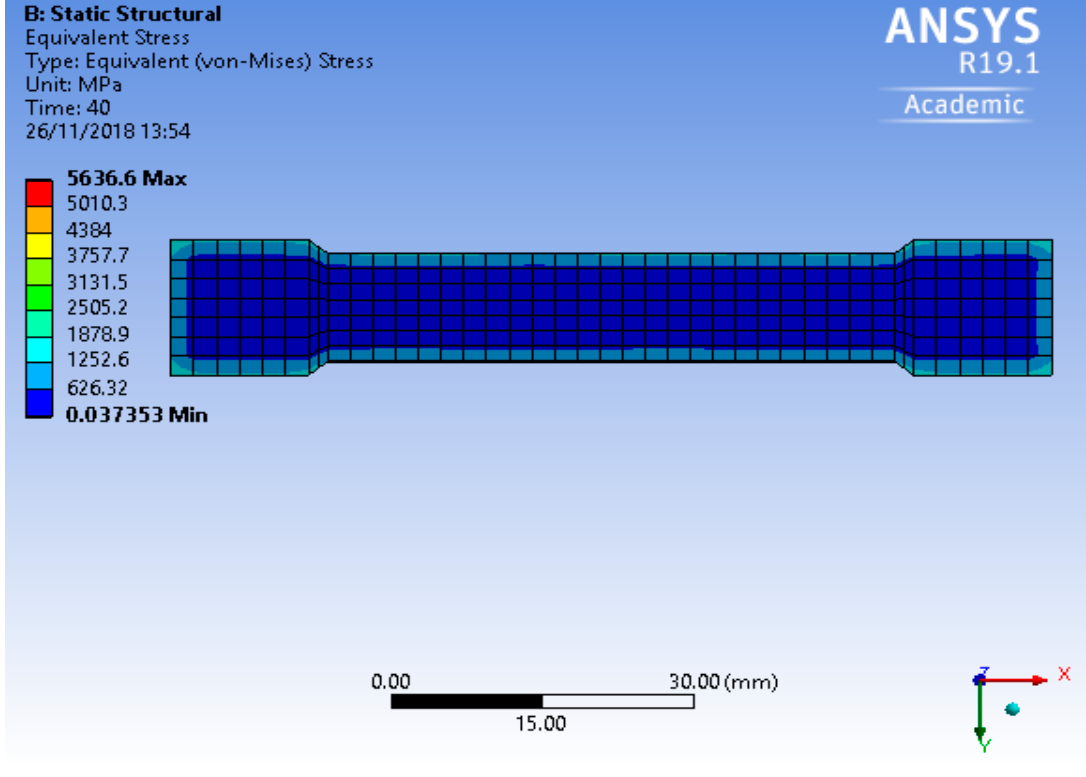
Figure 10. Thermal stress on the foil adjacent to the cold plate. J. Compos. Sci. 2018 , 2 , x